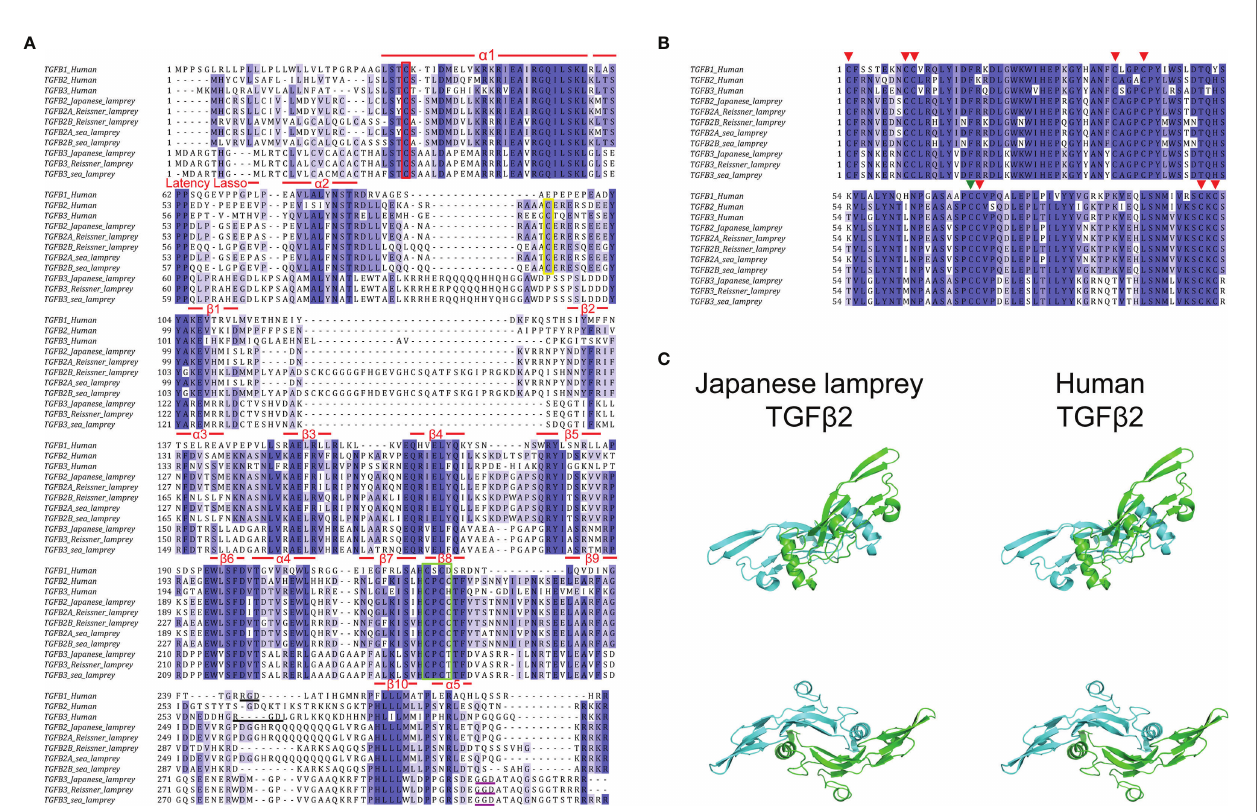
FIGURE 2 | Amino acid sequence alignment of TGF- b s between lampreys and humans. (A) Alignment of the prodomains of TGF- b s between lampreys and humans. The sequence features of the straitjacket domain and the arm domain are shown above the alignment. Conserved cysteine residues involved in the formation of the TGF- b large latent complex (LLC) are highlighted in the red box, green box, and green box, respectively. The Arg-Gly-Asp (RGD) sequences in human TGF- b 1 and TGF- b 3 are highlighted by black underline. The Gly-Gly-Asp (GGD) sequences in lamprey TGF- b 3 are highlighted by purple underline. (B) Alignment of the ligand domains of TGF- b s between lampreys and humans. The eight conserved cysteine residues forming four intramolecular disul fi de bonds are marked by the red arrows above the alignment. The other cysteine residue involved in the formation of intermolecular disul fi de bonds that link the two monomers into a dimer is marked by the green arrow. (C) Protein structure comparison of TGF- b 2 mature peptide between Japanese lamprey and human. The molecular model of lamprey TGF- b 2 mature peptide homodimer was built by homology modeling of SWISS-MODEL based on the human TGF- b 2 (PDB code 2tgi.1.B). The two monomers of TGF- b 2 are shown in blue and green, respectively. Two views are displayed, rotated by 90° with respect to each